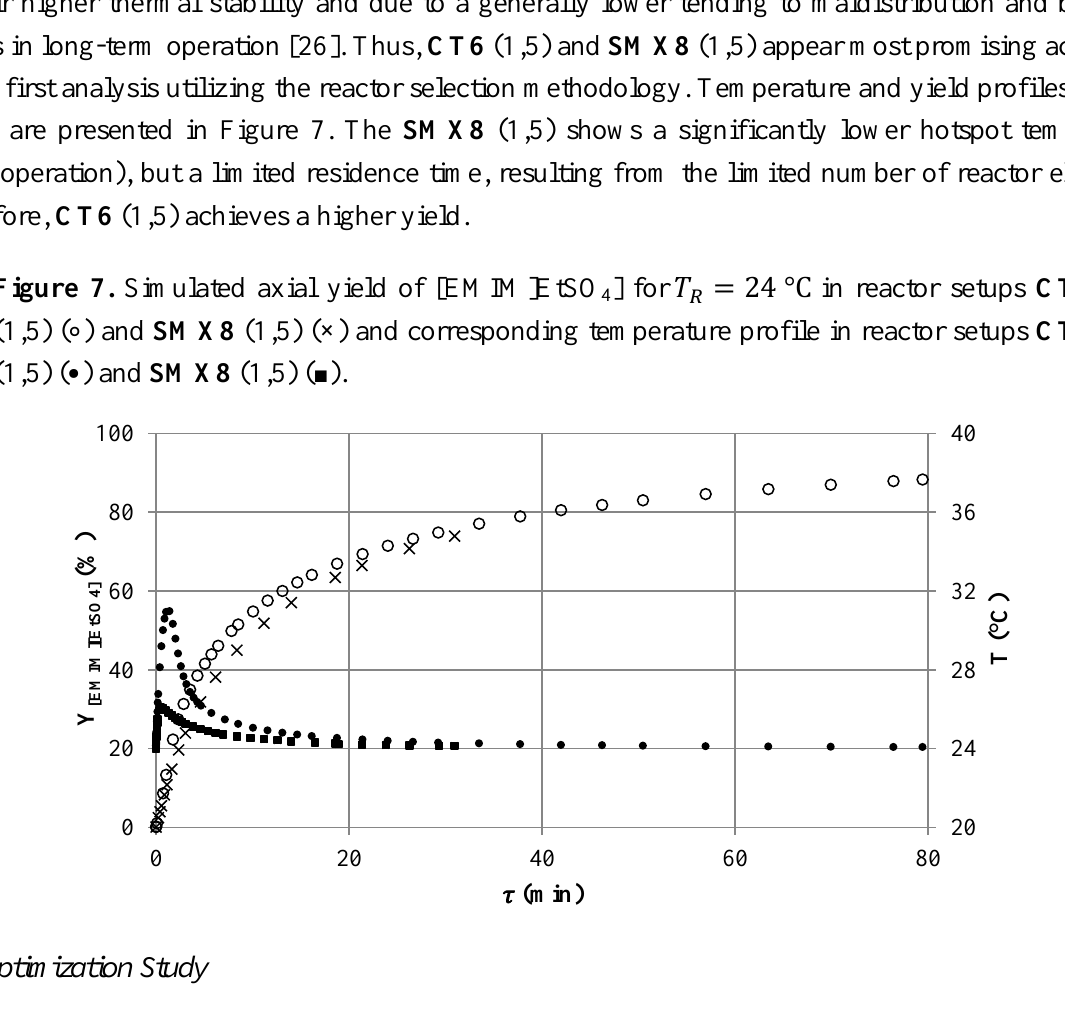
] for in reactor setups CT6 4